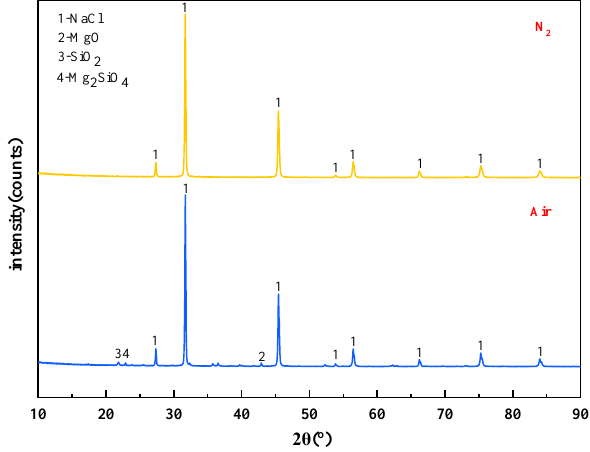
Figure 14. XRD of filtrate obtained with different atmosphere.